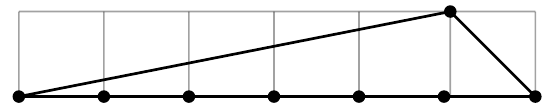
Figure 24. The toric diagram of C 2 / Z 6 , as an example of the C 2 / Z 2 m